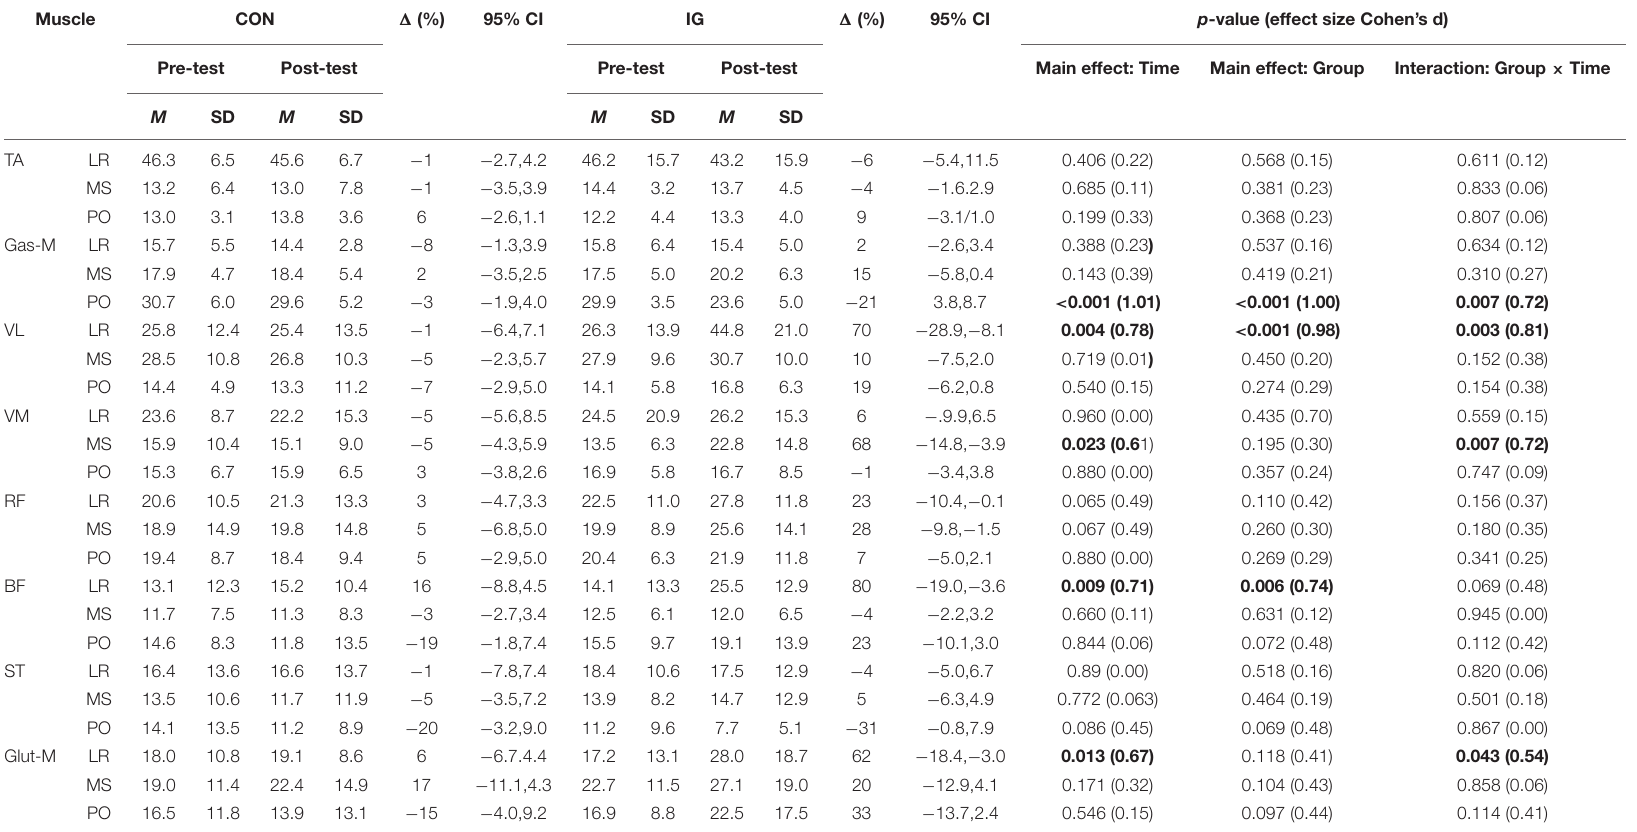
TABLE 6 | Group-specific normalized muscle activities (% MVIC) during walking at constant speed before and after training. Muscle